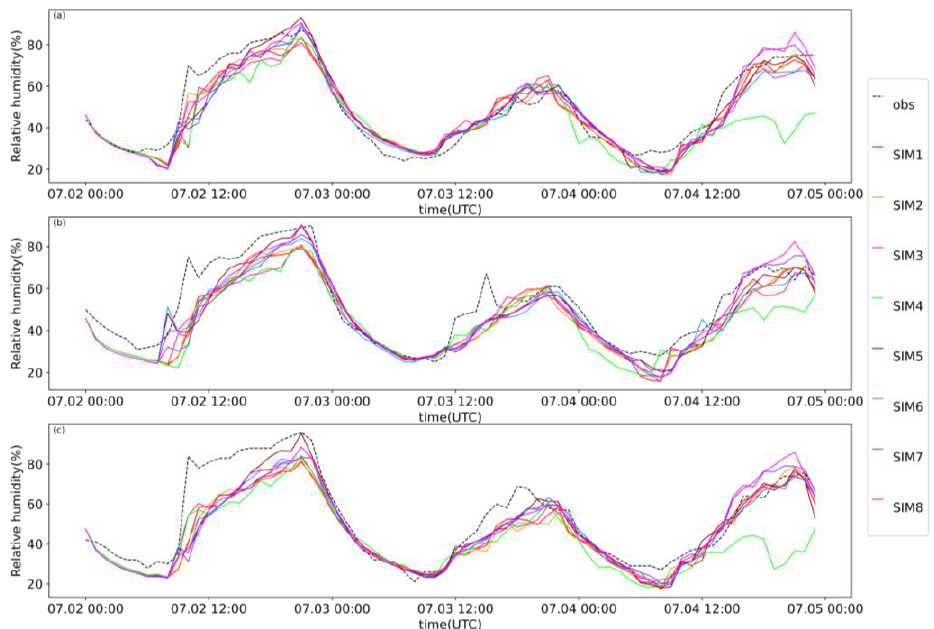
Figure 6. Time series of observed and simulated 2-m relative humidity at 3 sites from 2–4 July at ( a ) Rongcheng: 54,503, ( b ) Xiongxian: 54,636, and ( c ) Anxin: 54,605 .